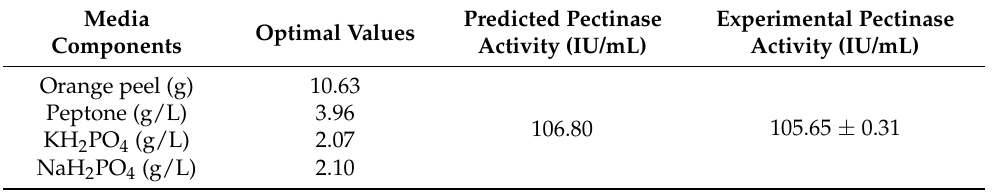
Table 13. Media components optimal values for pectinase